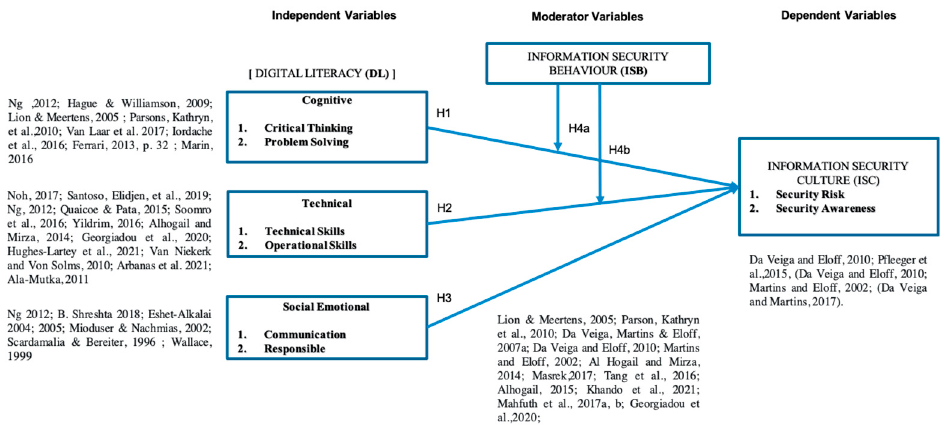
Figure 1. Proposed Research